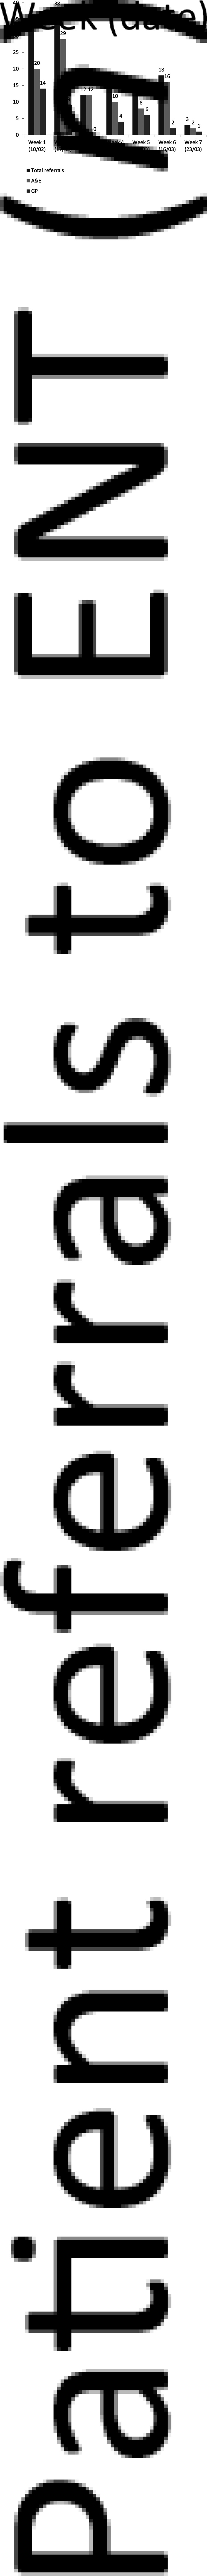
Numbers of weekly referrals and referral source (primary care vs accident and emergency department) over the study period. A&E = accident and emergency; GP = general practitioner